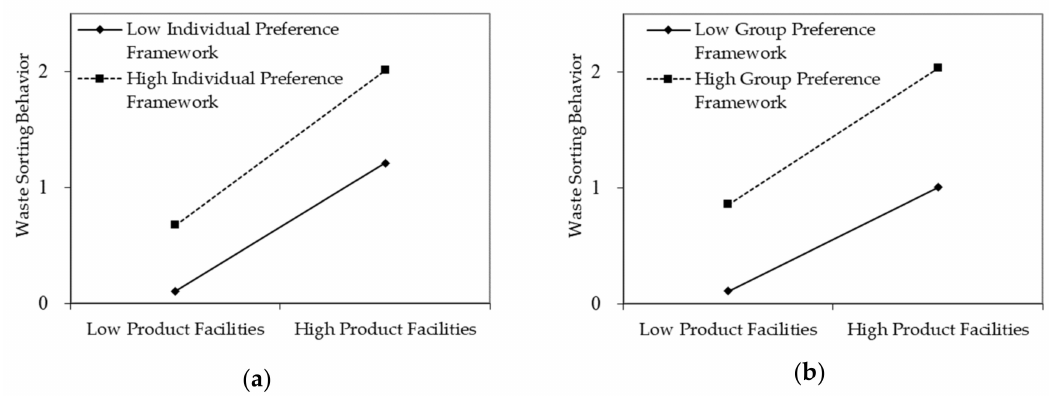
Figure 2. ( a ) The regulating e ff ect of individual preference framework on waste-sorting behavior; ( b ) the regulating e ff ect of group preference framework on waste-sorting